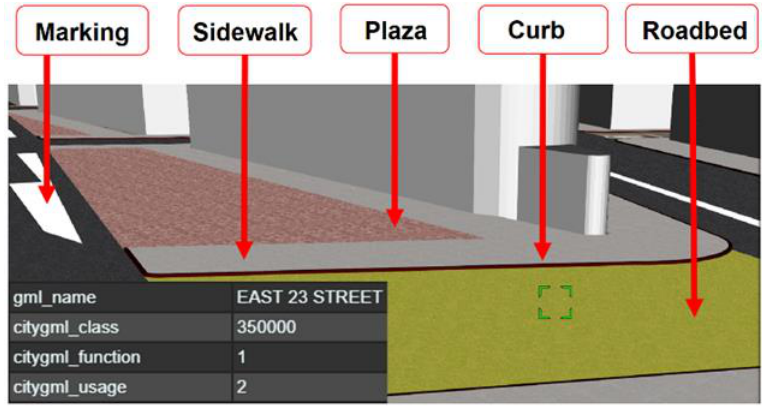
Figure 11. Detailed street representation.